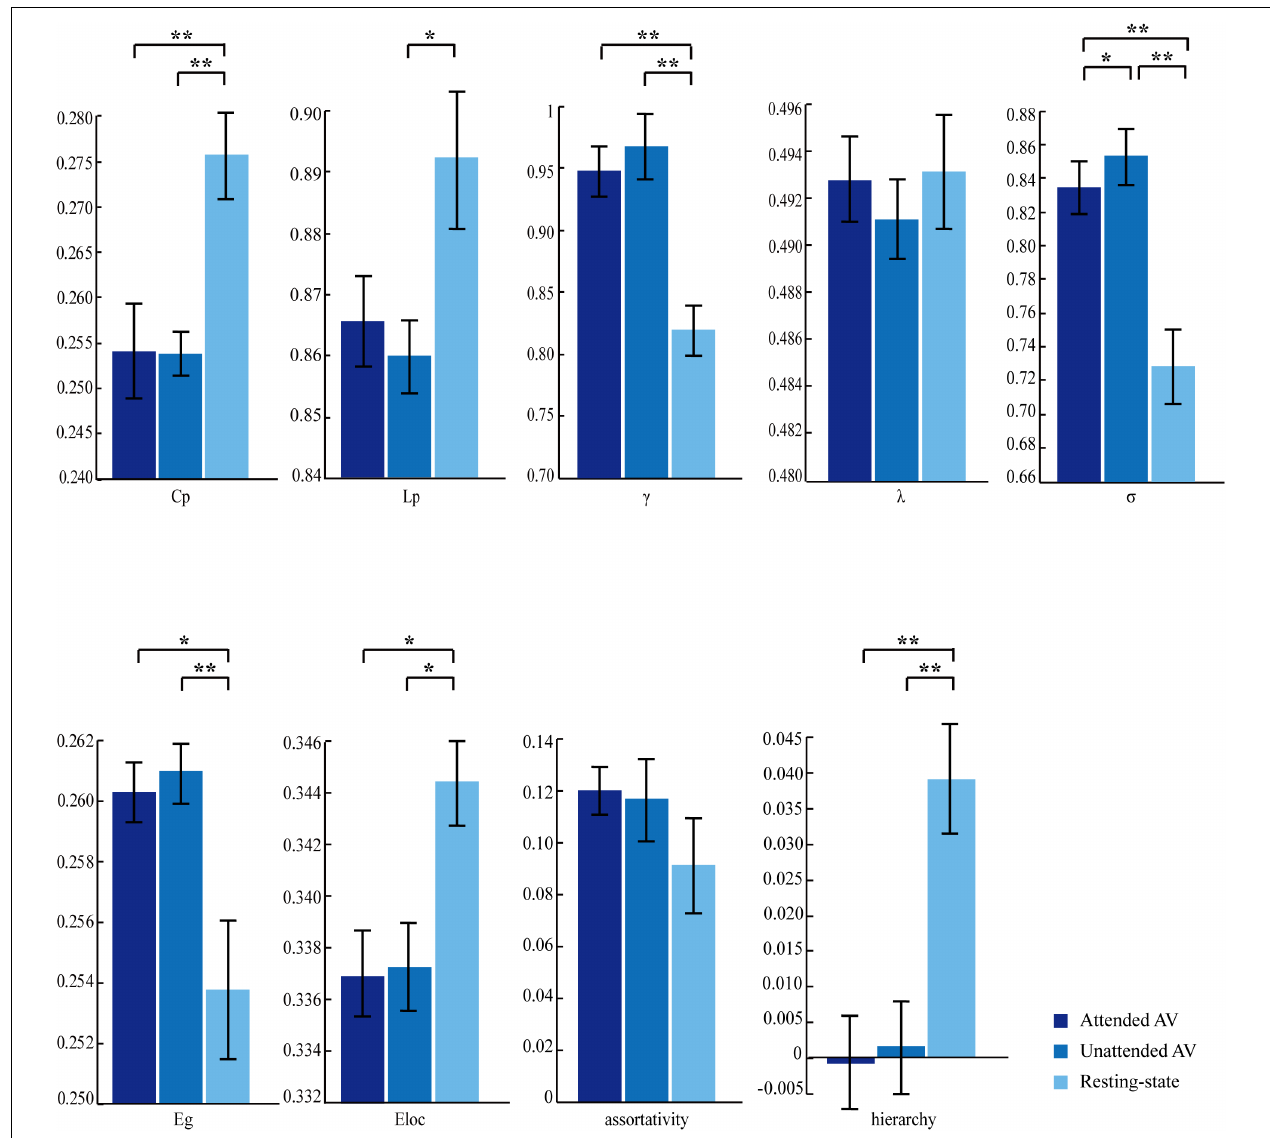
FIGURE 5 | Effects of the attended AV, unattended AV, and resting-state conditions on the graph theory metrics of global properties. Cp, clustering coefficient; Lp, characteristic path length; γ , normalized clustering coefficient; λ , normalized characteristic path length; σ , small-worldness; Eg, global efficiency; Eloc, local efficiency. ∗ p < 0.05, ∗∗ p <